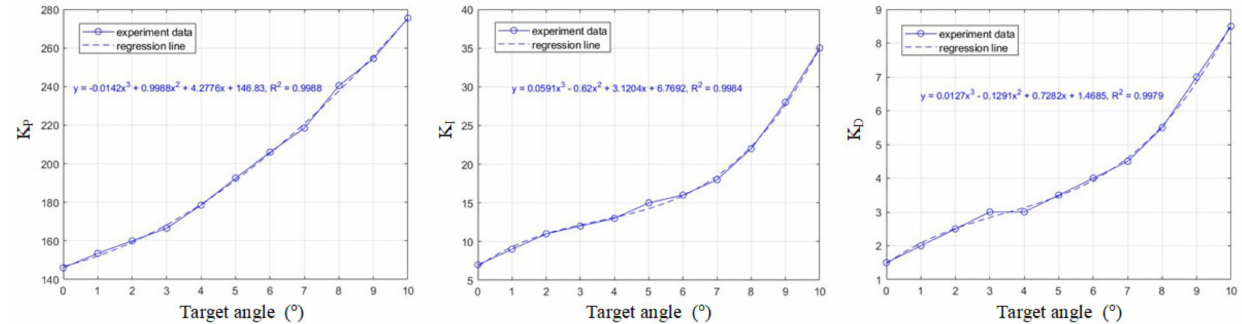
Figure 10. Control gains are adaptively changed with the target angle.